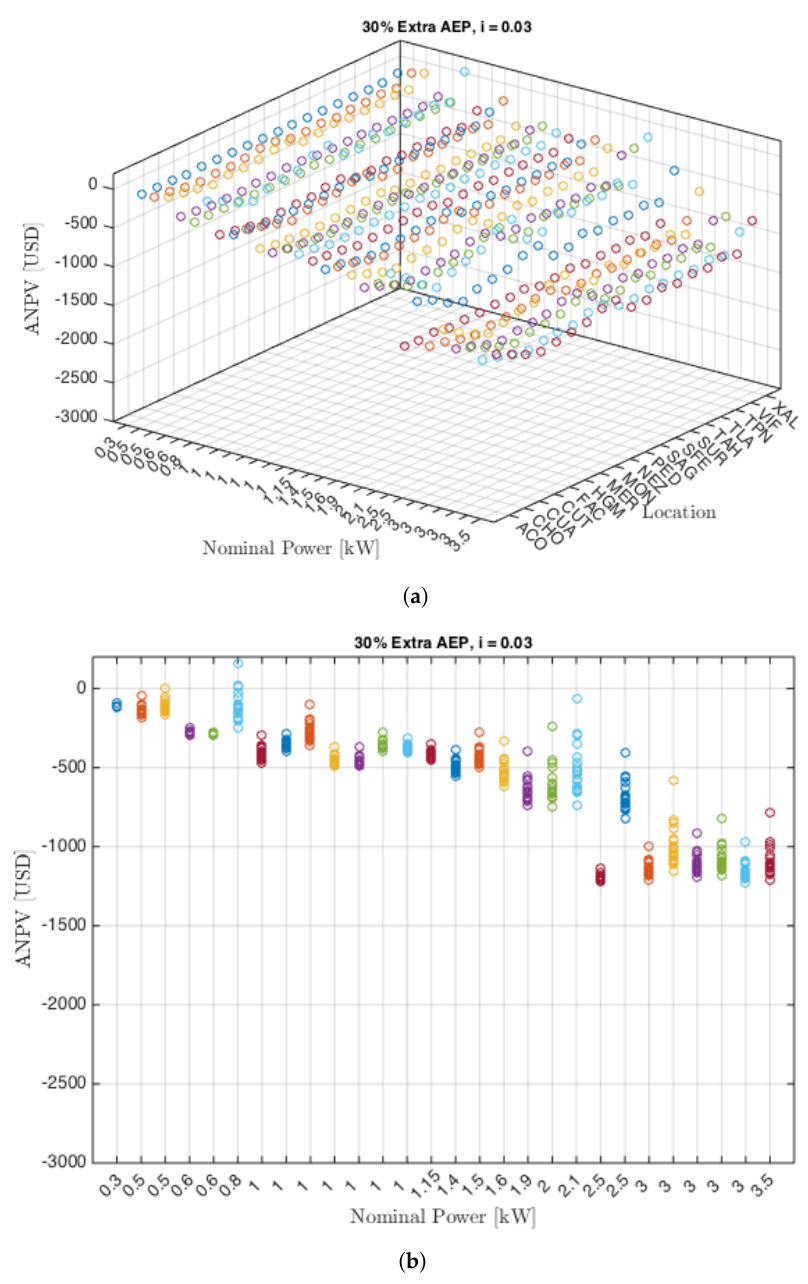
Figure 10. ANPVs are calculated for the 18 sites, where 28 SWTs are assessed. Economic conditions are as follows: cost of energy with the Domestic High Consumption (DAC) electric tariff, benefits proportional to AEP , which considers 30% extra energy to approximate the SWT case, and a 3% discount rate. Values repeated along the nominal power axis represent different wind turbine models with equal nominal power. ( a ) Annualized net present values ANPVs calculated for all sites and SWTs ; ( b ) The location axis is removed, and similar behavior is observed for all SWTs ; wind conditions appear similar within the Valley of Mexico Metropolitan Area